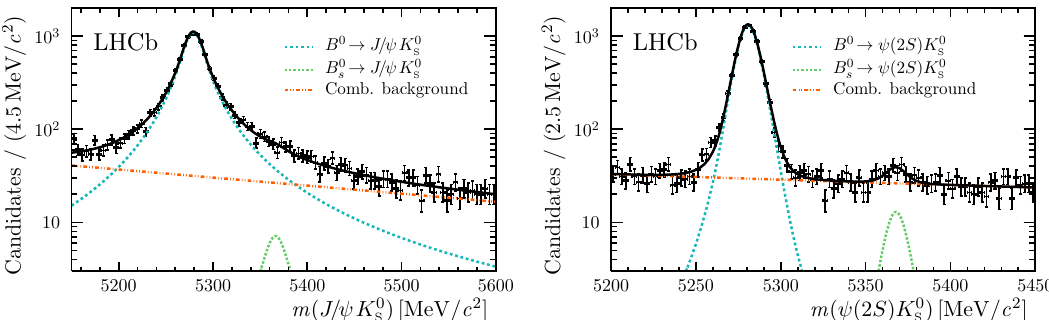
Figure 1 . Invariant mass of the B 0 candidates for (left) the J= and (right) the (2 S ) mode. The lines represent the result of the (cid:12)t described in the